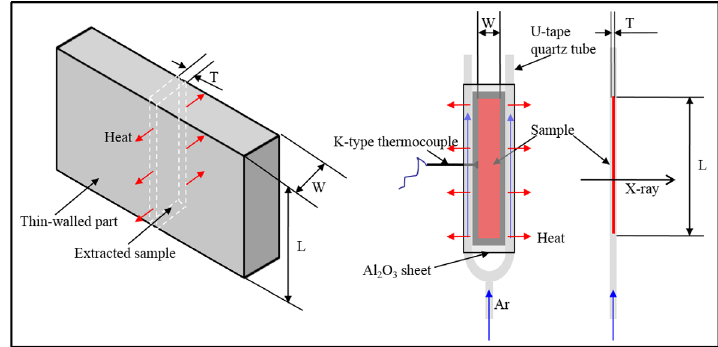
Figure 1. Schematic of the thin-walled sample and the cooling method. W = width, L = length, T =